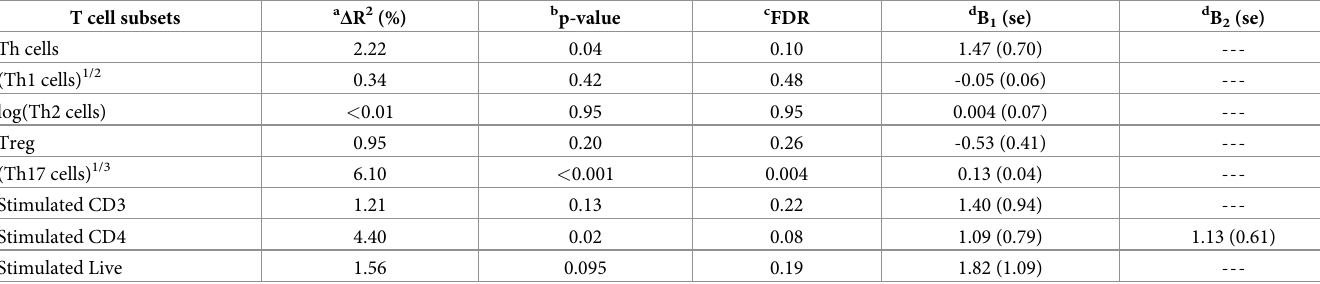
Table 4. Association between urinary arsenic concentration per creatinine (UAs/Cr) and T cell subsets (n = 180). T cell subsets